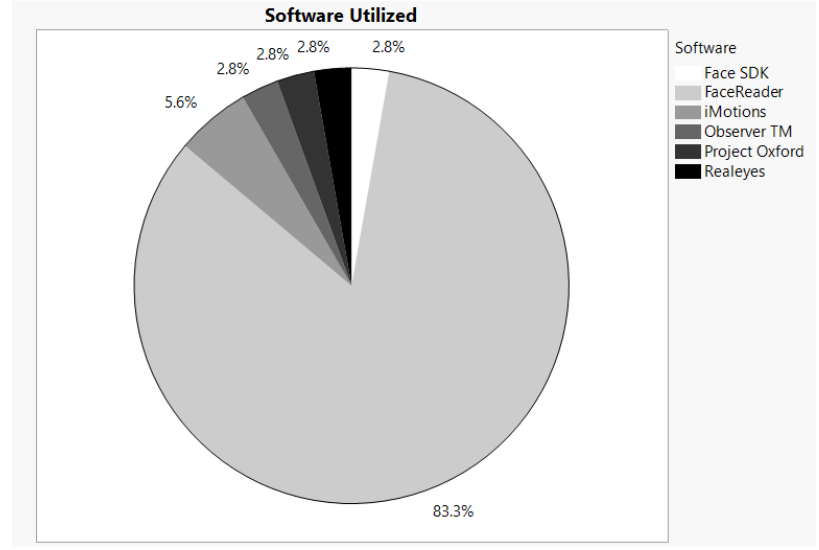
Figure 9. Comparison of AFEA software utilized across the 38 studies related to AFEA, beverages, and/or packaging.